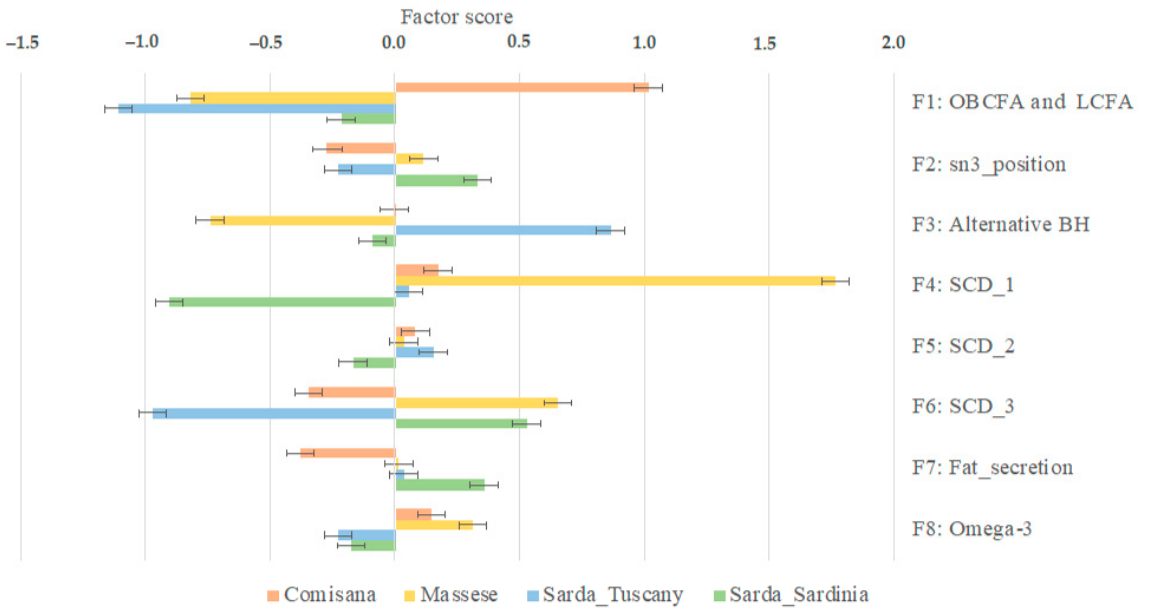
Figure 1. Effect of breed on the factors extracted by multivariate factor analysis. Legend: F1 = factor 1; F2 = factor 2; F3 = factor 3; F4 = factor 4; F5 = factor 5; F6 = factor 6; F7 = factor 7; F8 = factor 8; OBCFA = odd branched-chain fatty acid; BH = biohydrogenation; SCD = stearoyl-CoA